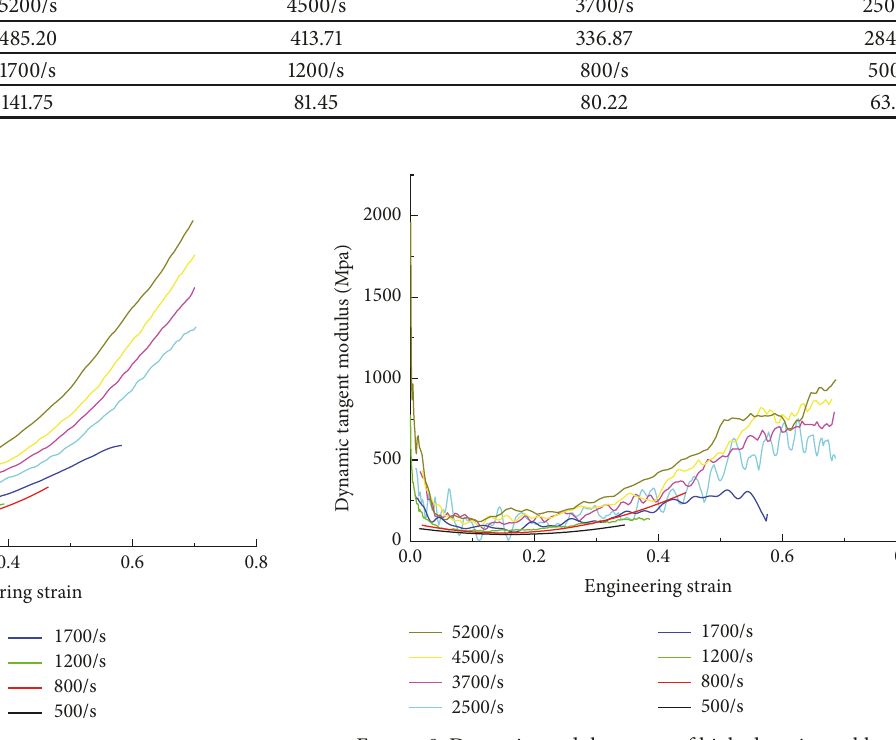
Figure 7: The final engineering stress-strain curves under different strain rates.